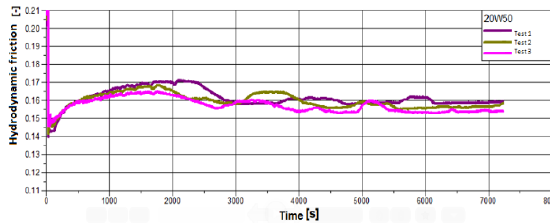
Figure 5: Diagram corresponding to the hydrodynamic friction with used oil (1000 km) in the measurement